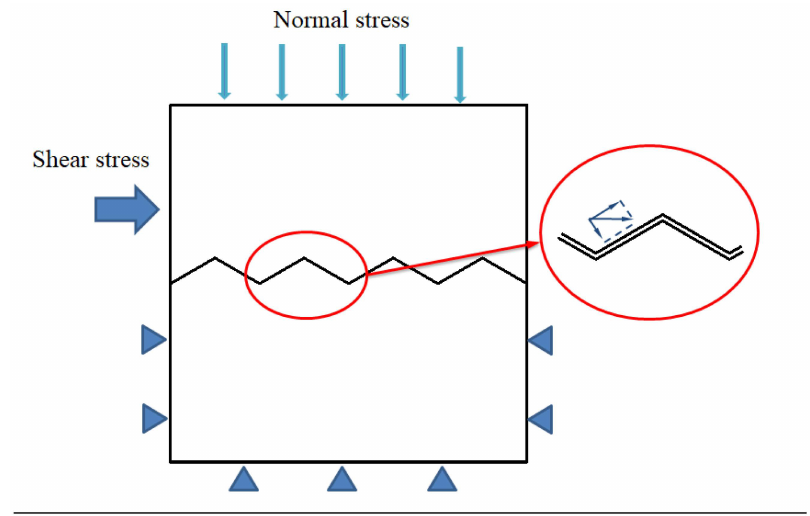
Figure 12. Stress diagram of